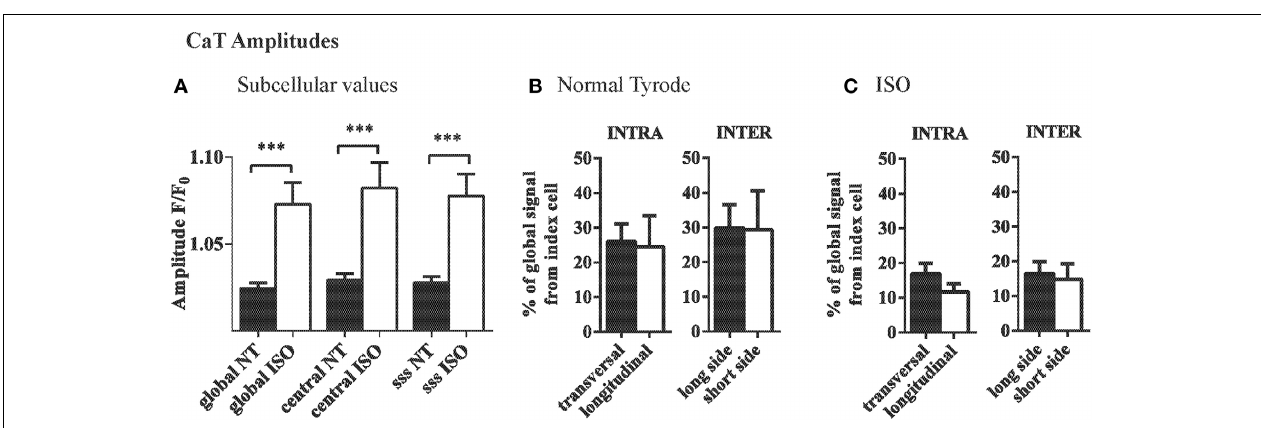
FIGURE 4 | INTRA- and INTERcellular variations in CaT amplitudes in the intact heart. (A) Average CaT amplitudes were equal in different subcellular locations of myocytes and compared to the global signal of that cell. ISO increased the CaT amplitudes but did not change that pattern. (B) Variation in CaT amplitude between ROIs as quantified by the mean absolute difference